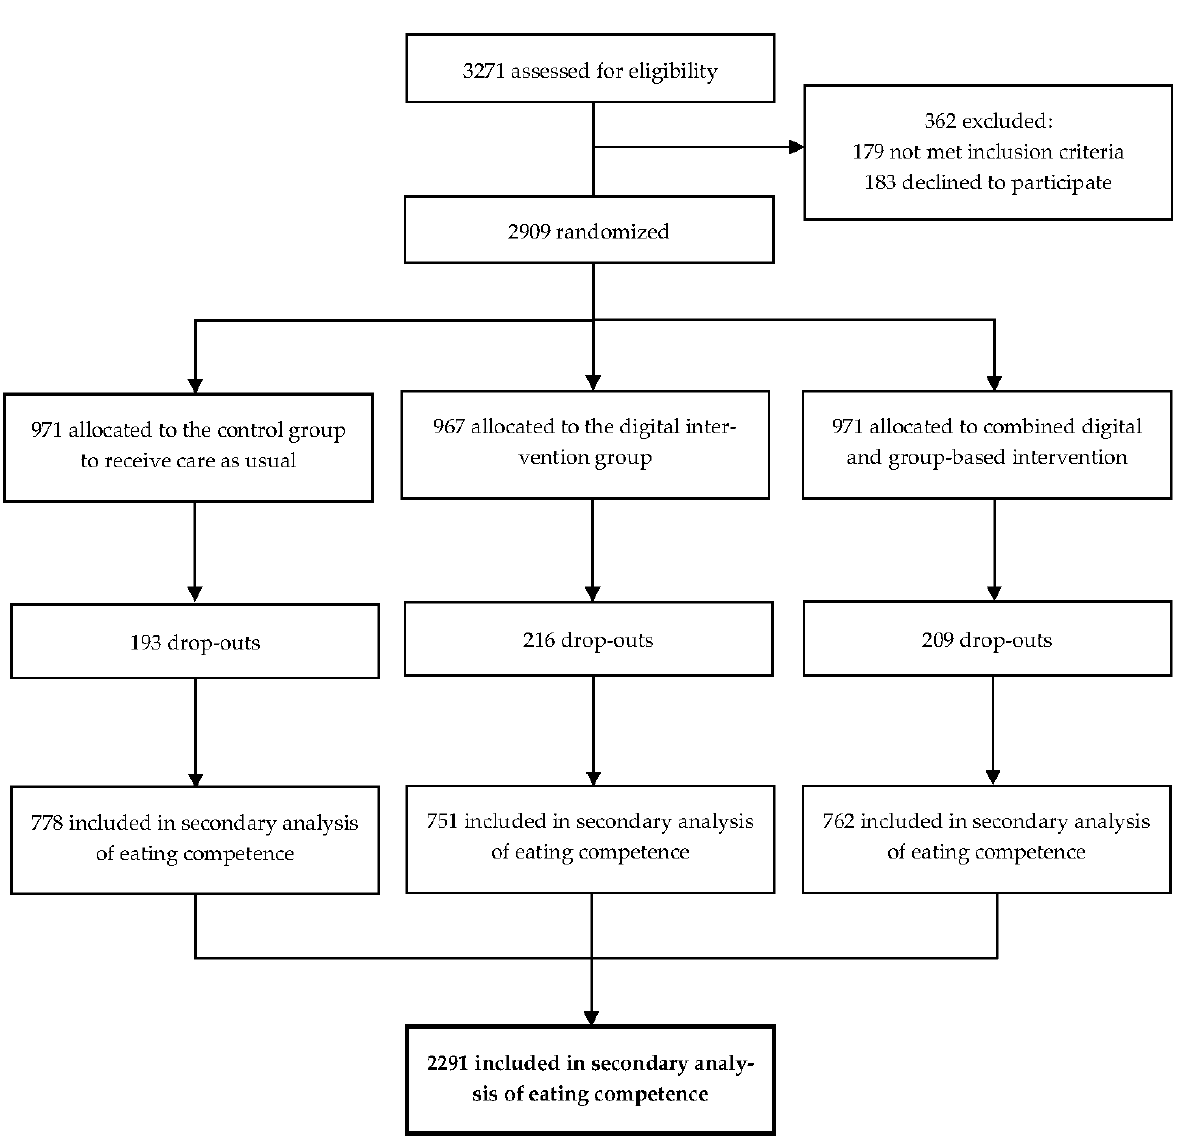
Figure A1. Flow chart describing how the study population of the present study (altogether 2291 participants, see the last row of the figure) was formed from the whole StopDia population ( n = 2909 [18]).